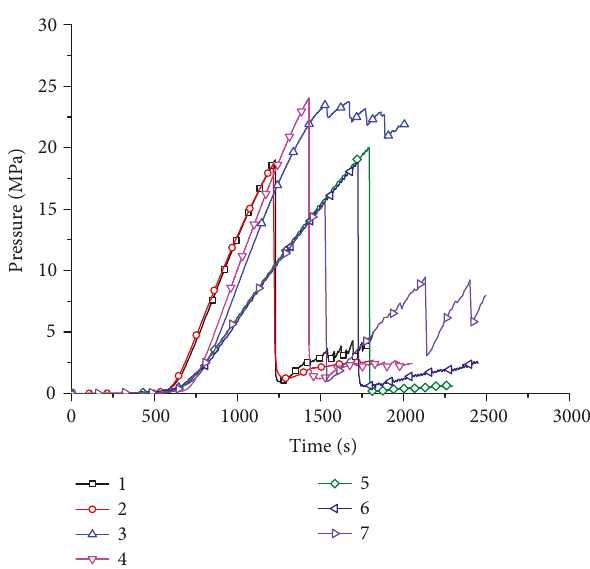
Figure 9: Pressure curves in the core fracturing process.